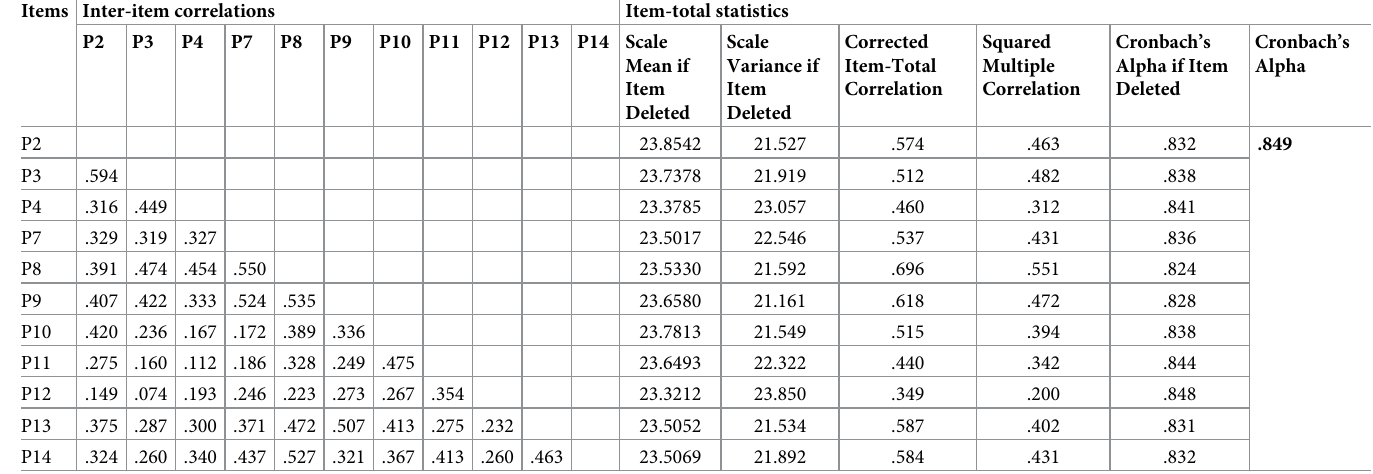
Table 5. Inter-item correlation and item-total statistics of items used to assess adherence to COVID-19 preventive practices among secondary school students in Jimma, Oromia, Ethiopia, 2022. Items Inter-item correlations